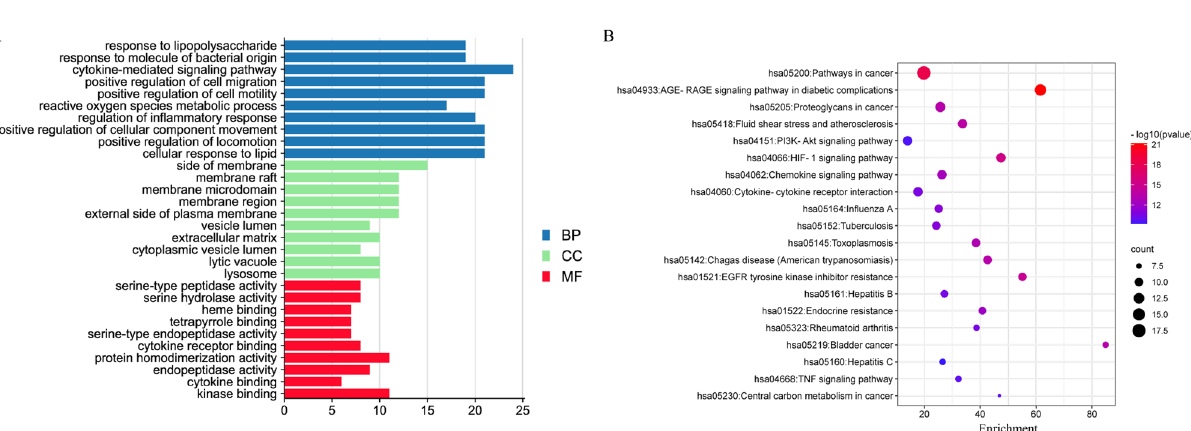
Figure 3. GO and KEGG enrichment analysis of 59 overlapping targets of TRQ for AECOPD treatment. ( A ) GO included GOBP, GOCC and GOMF. ( B) The size of the bubbles of KEGG represented the gene counts, the color from cold to warm of the bubbles represented the P-value from large to